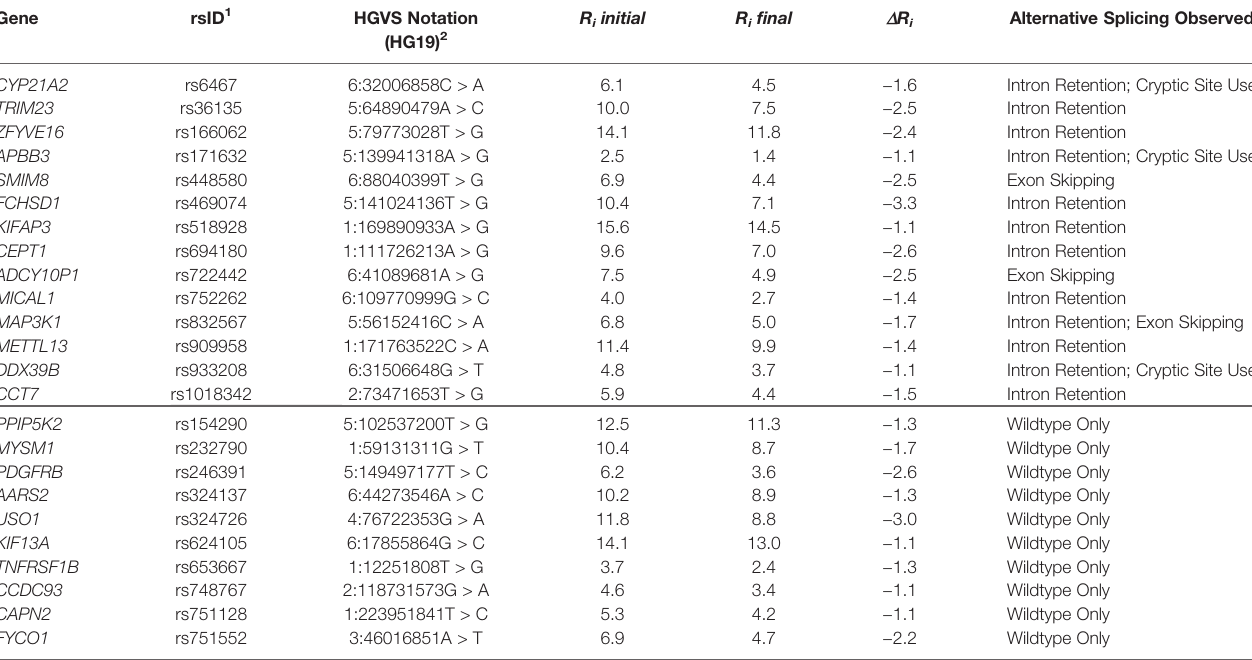
TABLE 3 | RNAseq analysis of natural splice sites weakened by common single nucleotide polymorphisms (SNPs). Gene rsID